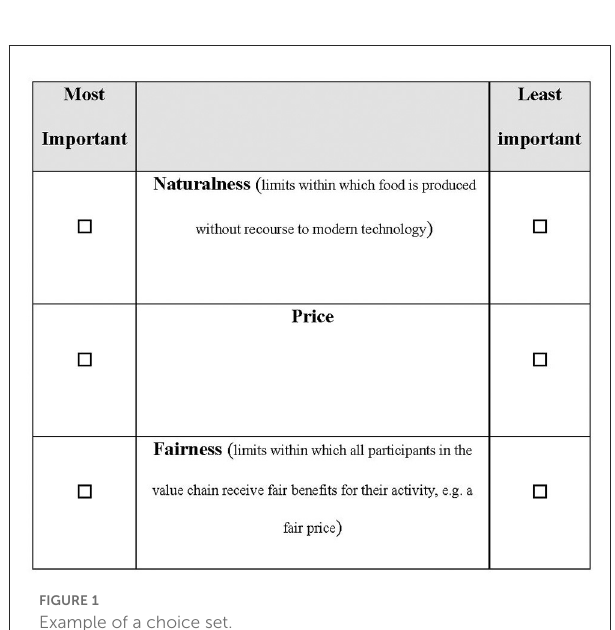
FIGURE1 Example of a choice